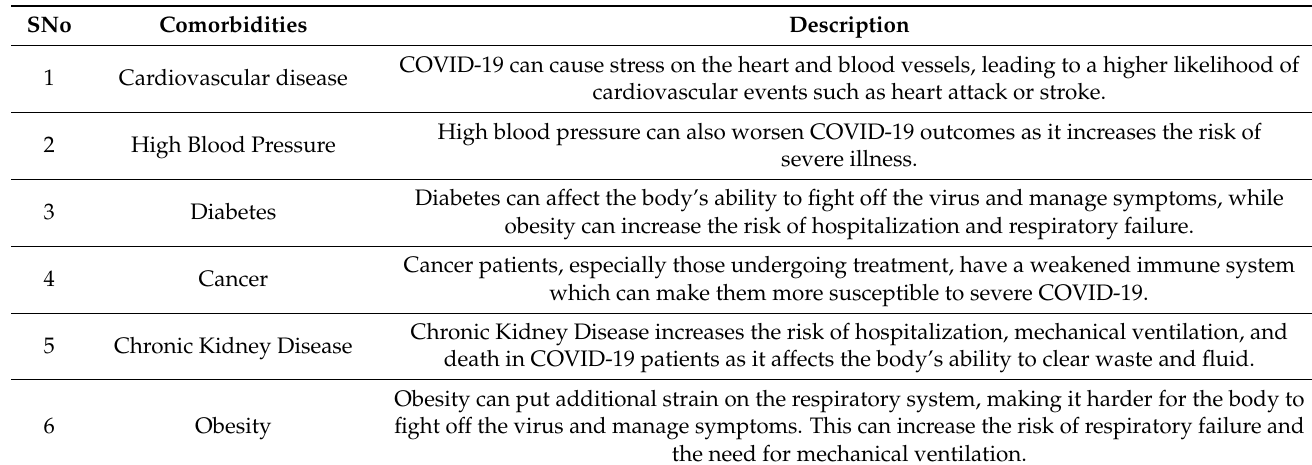
Figure 5. Two-dimensional tSNE embedding of the 512-D feature space along with neighborhoods considered during relevant case retrieval. The red circle represents immediate neighbors whereas the blue circles indicate second stage neighbors. Each point represents a CXR embedding into the feature space along with the associated variables. Table 1. Comorbidities considered in this study in COVID-19